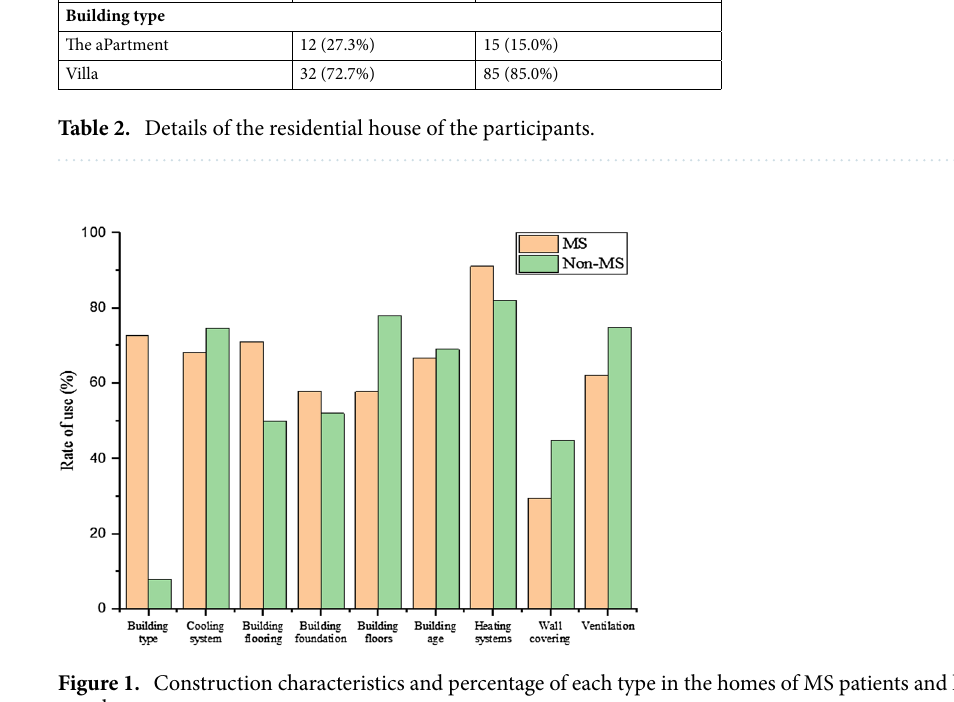
Figure 1. Construction characteristics and percentage of each type in the homes of MS patients and healthy people.